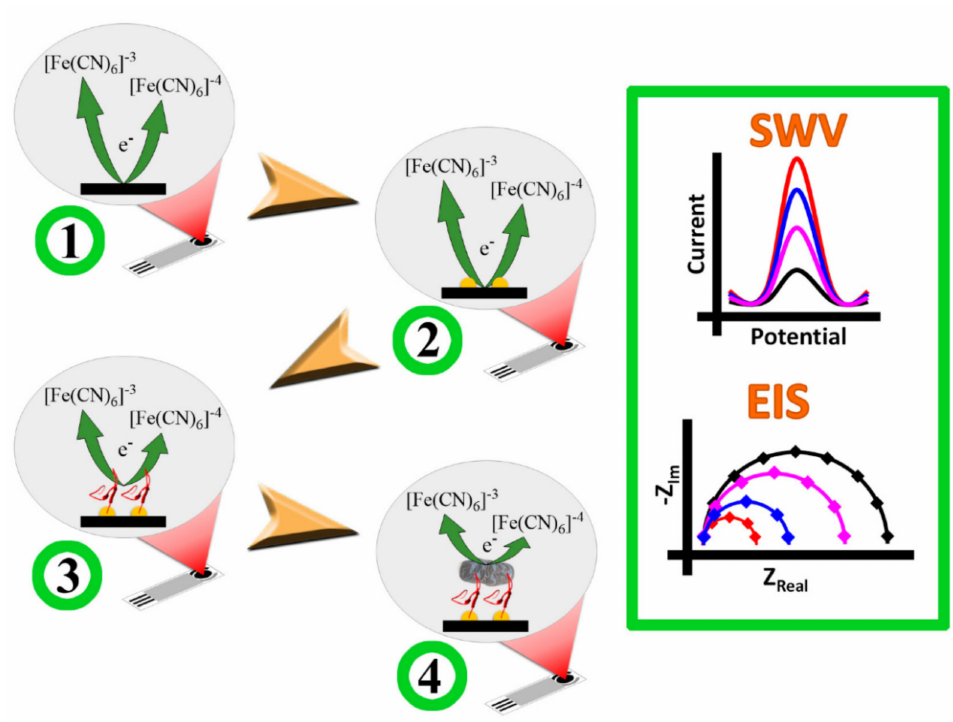
Figure 3. The biosensor’s construction and E. coli detection are depicted in this diagram. In the SWV and EIS curves, the electrochemical behaviour of the unaltered (SPE) electrode in step 1 (left) is schematically illustrated by black lines (right). SPE/ gold NPs (step 2 in left, red lines in SWV and EIS), SPE/ gold NPs /PEP (step 3 in left, blue lines in SWV and EIS), and SPE/ gold NPs /PEP/EC are the electrode’s expected responses (step 4 in left, rose lines in SWV and EIS). Reprinted from Ref.